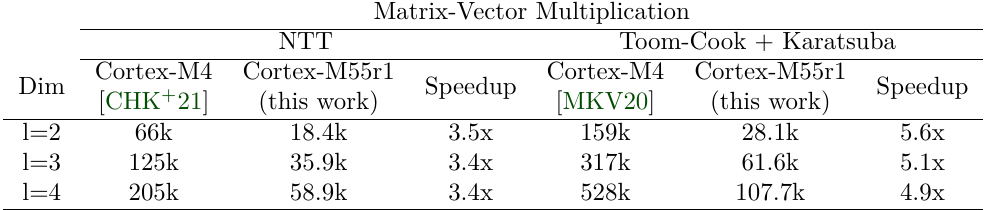
Table 5 Comparison of different approaches for Matrix-Vector multiplication.